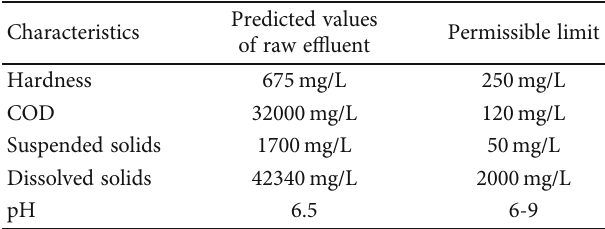
Figure 15: 2-D plot of adsorption desorption progression cycles on on di ff erent runs. JPAC and JPAC/TiO 2 Table 7: Characteristics of waste